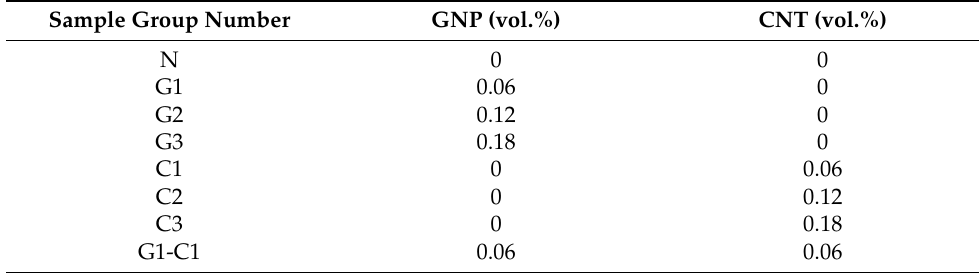
Table 2. The composition of the test samples.